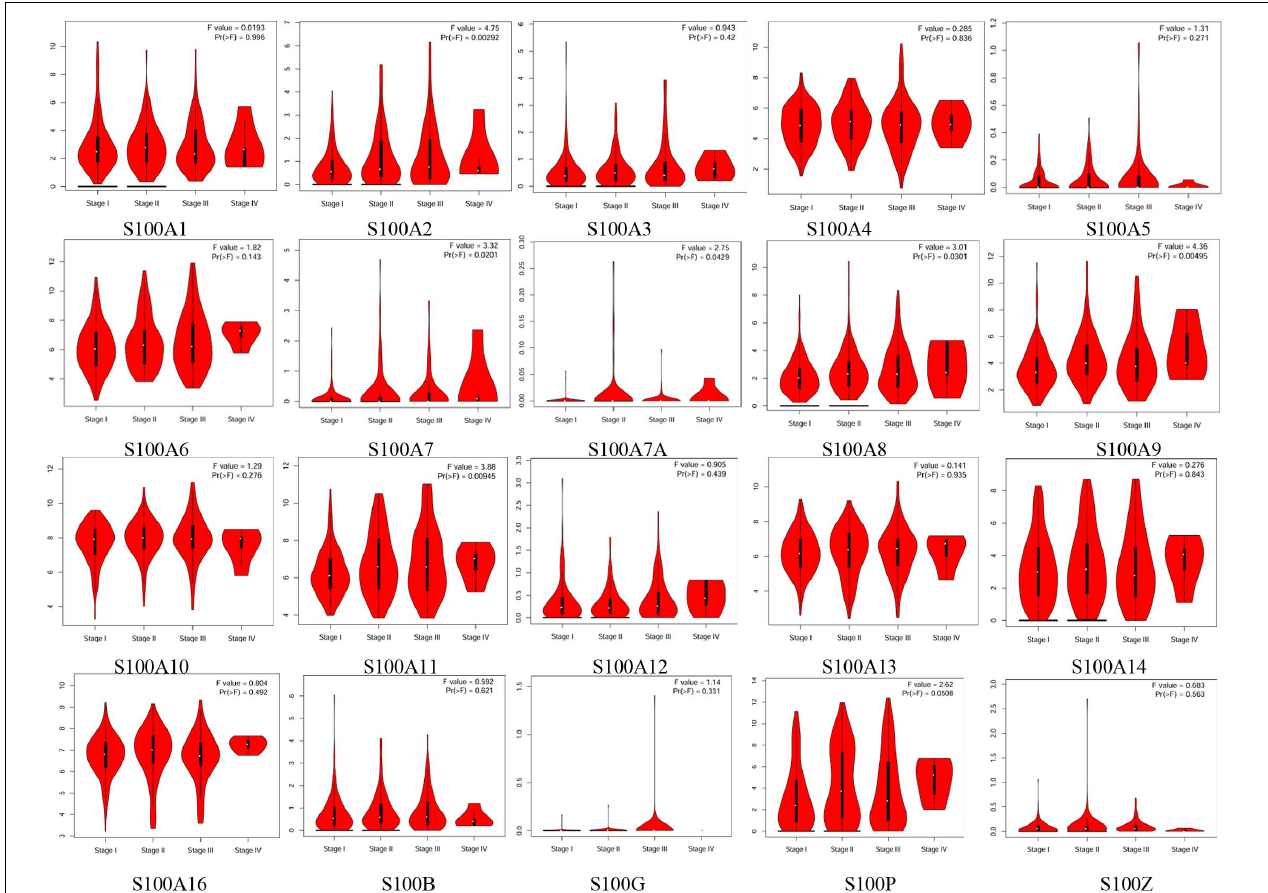
FIGURE 3 | Correlation between S100s mRNA levels and tumor stage in HCC patients (GEPIA database). The mRNA levels of S100A2/S100A7/S100A7A/ S100A8/S100A9/S100A11 were correlated with advanced tumor stage. A p < 0.05 was considered statistically